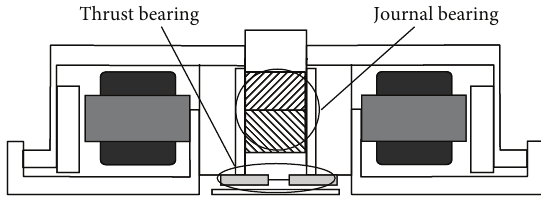
Figure 1: Bearings in spindle motor.